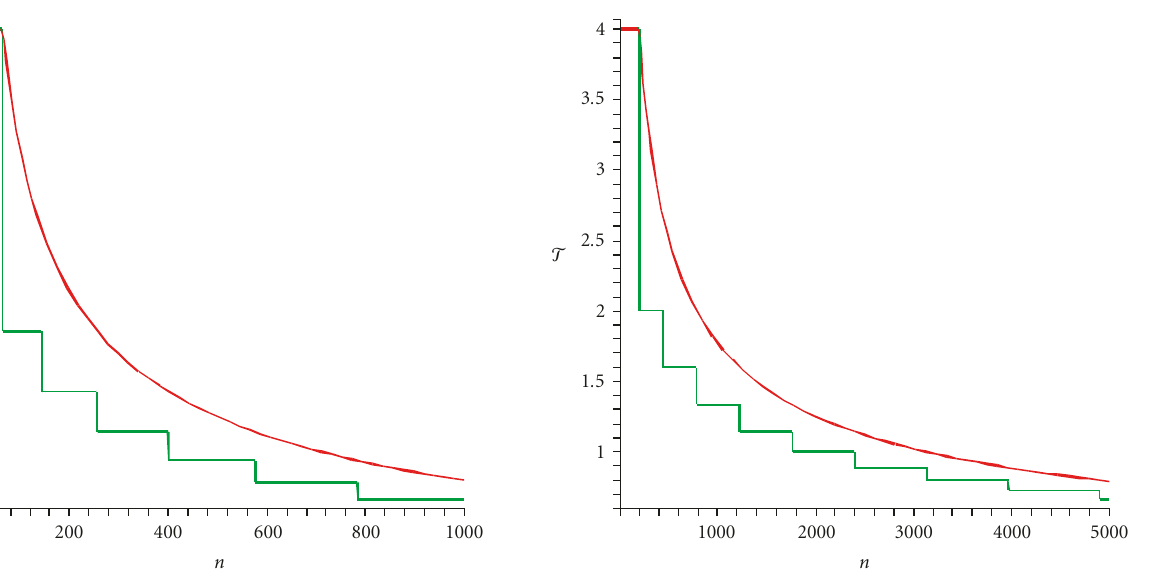
Figure 10: Throughput T versus n (upper and lower bounds) for beamwidth of 25 degrees.